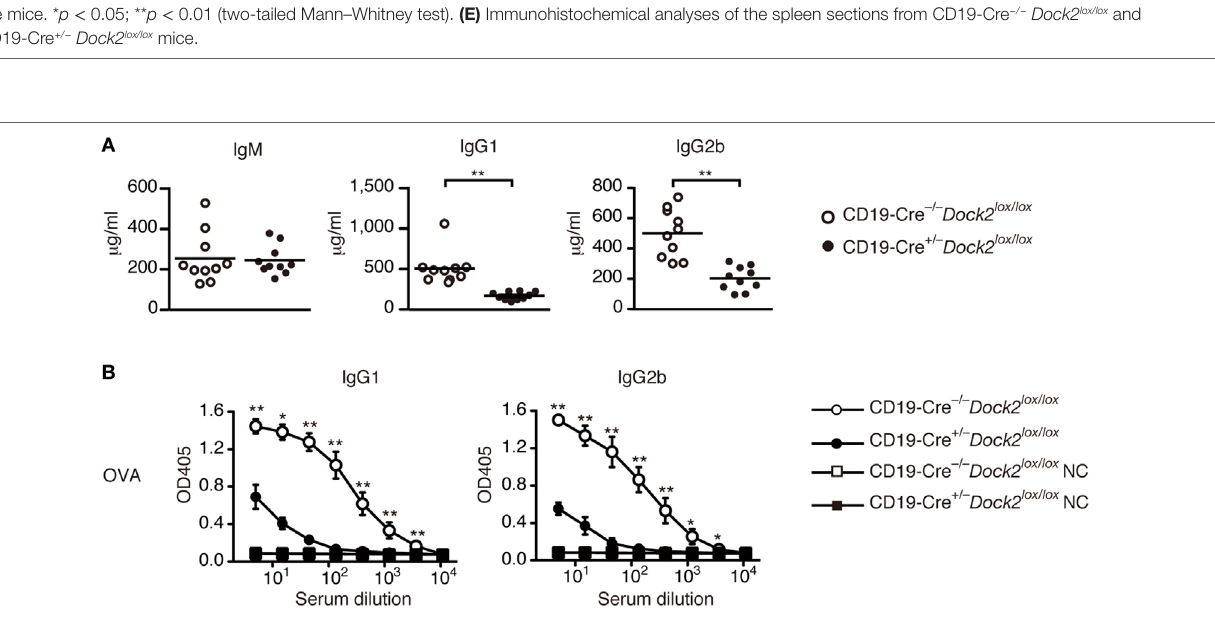
FigUre 6 | Defective antibody production in CD19-Cre + / − Dock2 lox/lox mice. (a) Comparison of serum IgM, IgG1 and IgG2b in CD19-Cre − / − Dock2 lox/lox and CD19-Cre + / − Dock2 lox/lox mice under the steady state. Data are indicated as the mean ± SD of 10 mice. ** p < 0.01 (two-tailed Mann–Whitney test). (B) OVA-specific antibody production was compared between CD19-Cre − / − Dock2 lox/lox and CD19-Cre + / − Dock2 lox/lox mice at day 14 after immunization. For negative controls, wells were coated with HEL. Data are indicated as the mean ± SD of five independent experiments. * p < 0.05; ** p < 0.01 (two-tailed Mann–Whitney